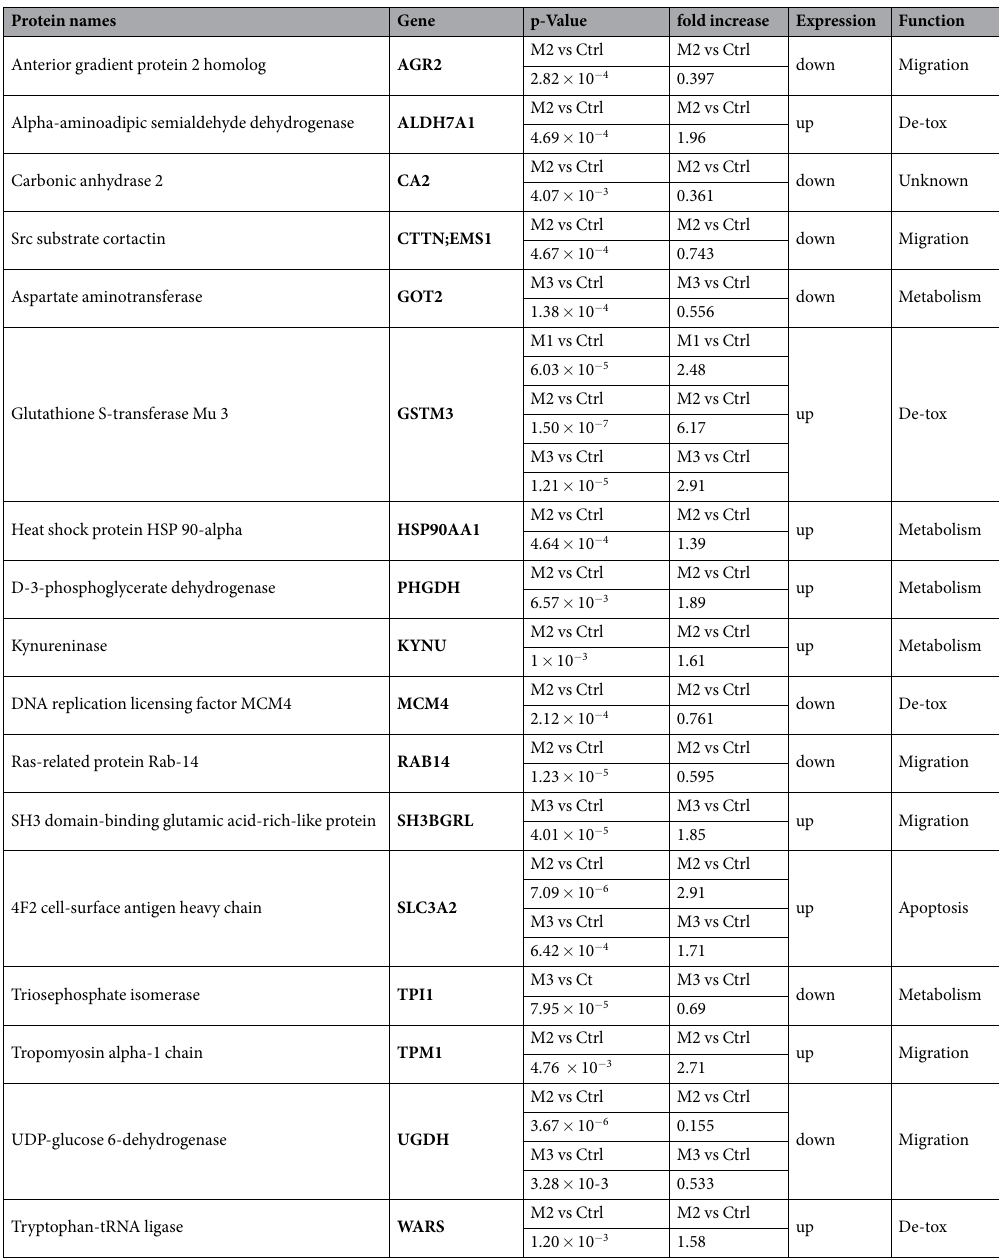
Table 2. Targets with significant difference between control and at least one clone: M1 or M2 or M3 vs. MCF7 and MCtrl.